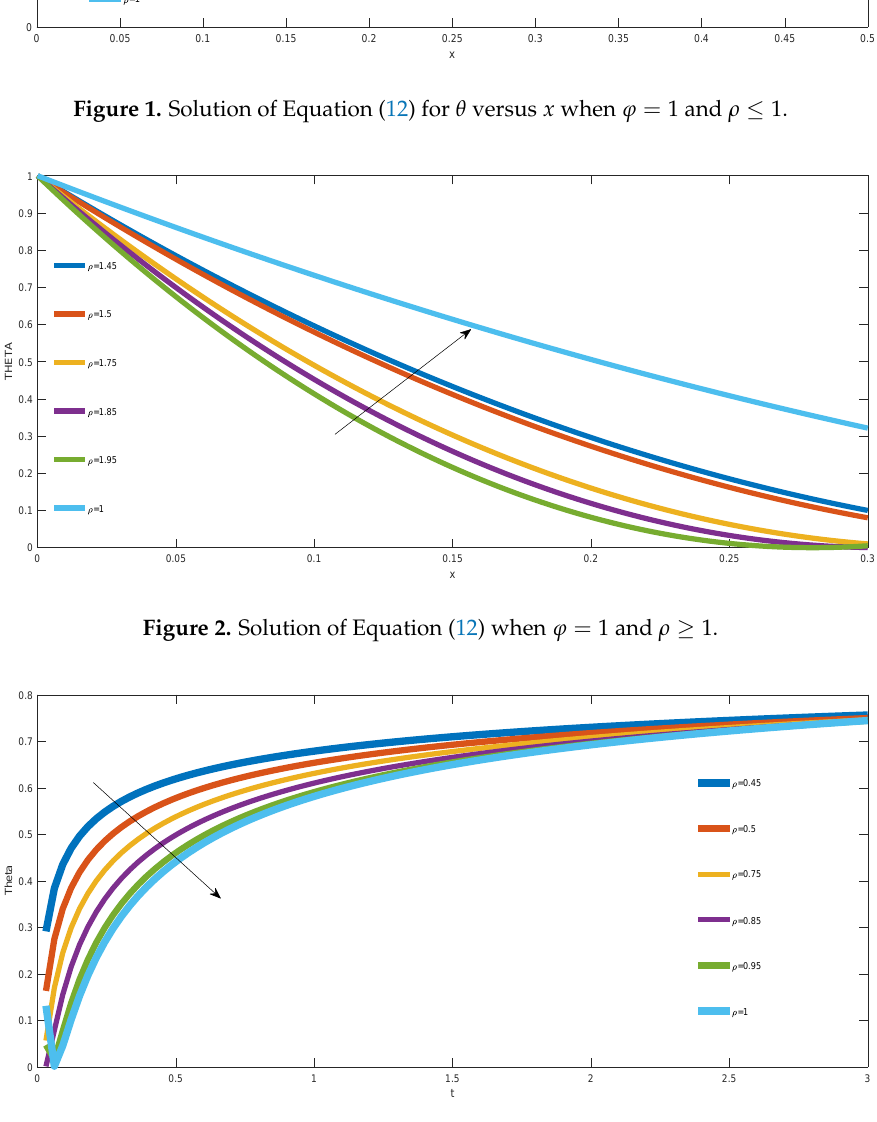
Figure 3. Solution of Equation (12) for θ versus t when ϕ = 1 and ρ ≤